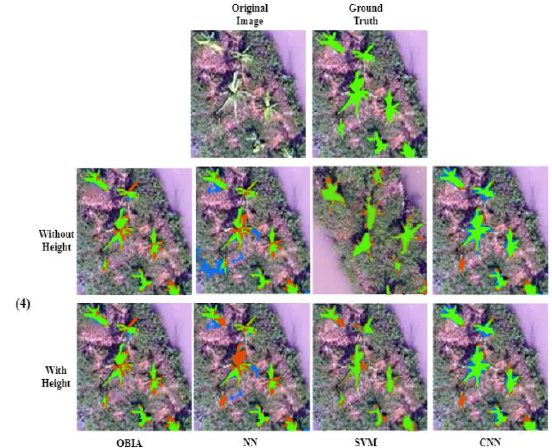
Figure 6. Visualization of prediction of four proposed model for Banana Tree Crown Delineation. Image id (3)